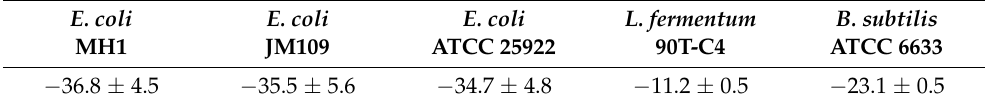
Table 3. ζ -potential (mV) of bacterial cells, pH 7.4 (0.02 M Na-phosphate buffer solution), 22 ᴼ C.